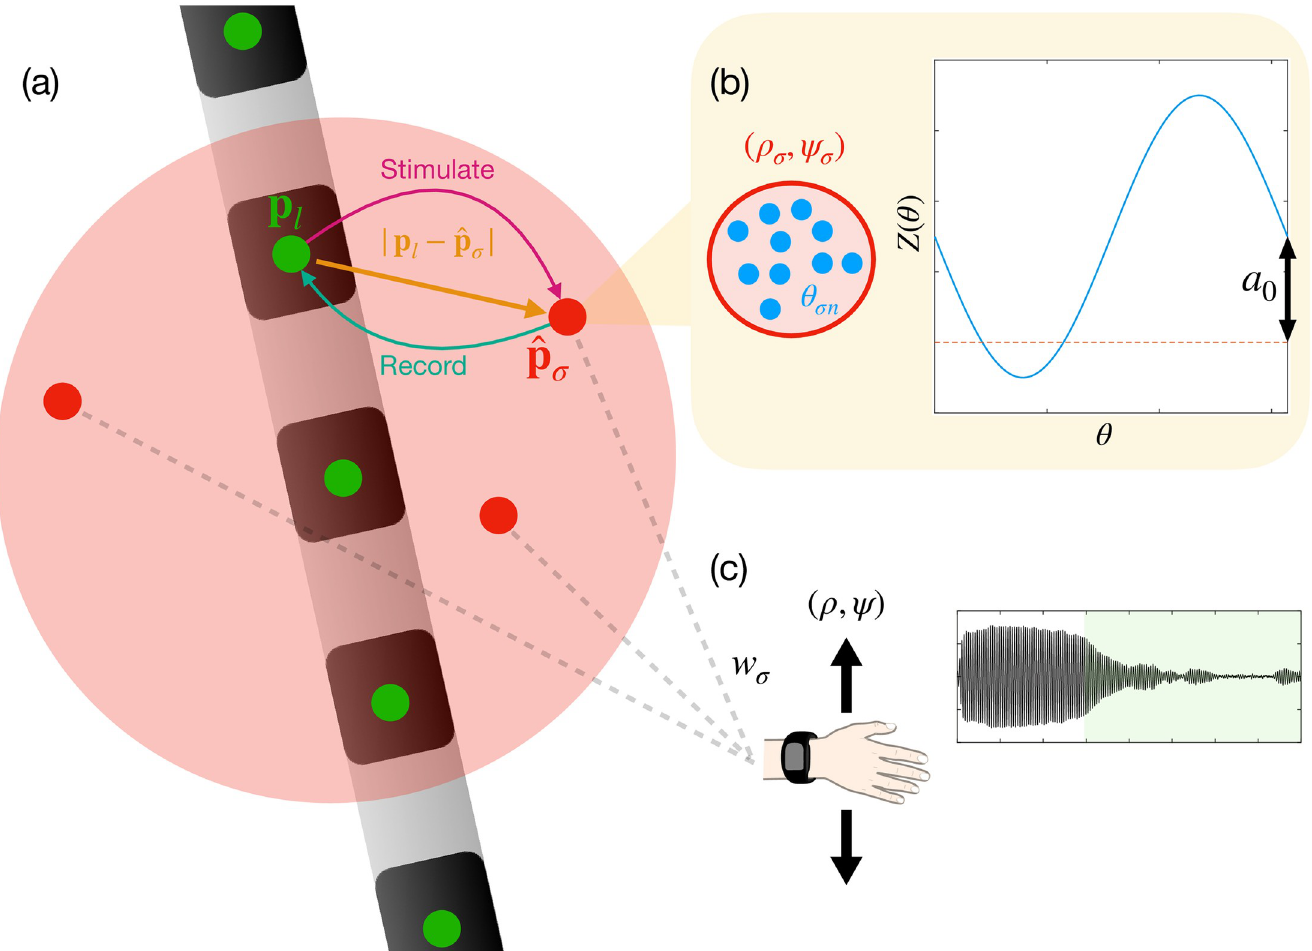
Fig 1. A model for closed-loop multi-contact DBS. (a) A multi-contact electrode is implanted into the VIM of the thalamus. Each contact (shown as green circles) delivers stimulation to and records from multiple coupled neural populations (shown as red circles), according to the geometry of the system. (b) We model each population as consisting of coupled neural units, shown as blue circles. Each unit is associated with a phase θ σn , which reflects where the neurons are in their firing cycle. The units of each population respond to stimulation according to a phase response curve Z ( θ ). The zeroth harmonic a 0 (or the vertical shift) of this function plays an important role in determining efficacy. Each population is associated with a local amplitude ρ σ and a local phase ψ σ , which are due to the collective activity of all units within the population. (c) The summed activity of multiple populations gives rise to symptoms, such as tremor in ET. The activities are summed according to a set of weights { w } and the resulting signal has an amplitude ρ and phase ψ . The amplitude ρ is correlated with the severity of tremor. When DBS with ACD is used σ (green region), the result is a reduction in ρ and thus the tremor severity. The effects are dependent on the positioning, measurement, and stimulation through multiple